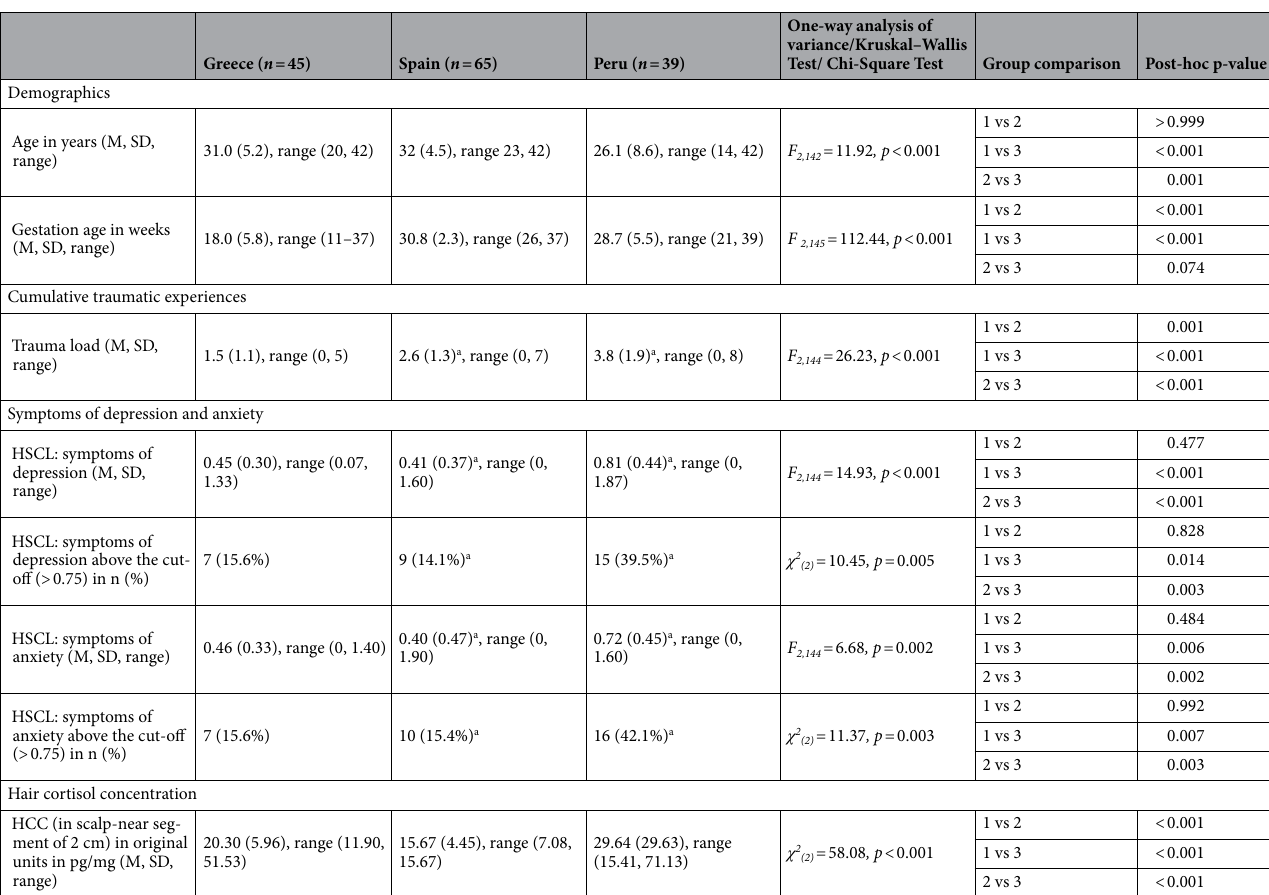
Table 1. Comparison of demographic data, number of different traumatic experiences (trauma load), symptoms of depression and anxiety and hair cortisol concentration (HCC in scalp-near segment of 2 cm) of the three different samples from (1) Greece, (2) Spain and (3) Peru. a Due to missing values data from n = 64 women Spain and n = 38 from Peru were available. HSCL Hopkins Symptom Checklist-25, HCC hair cortisol